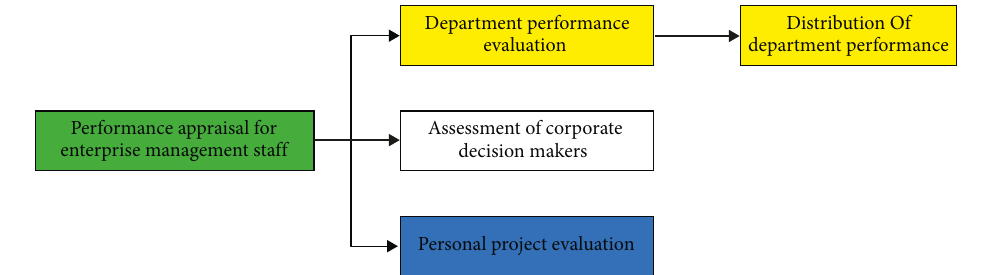
Figure 3: Main components of enterprise management employees’ performance appraisal.